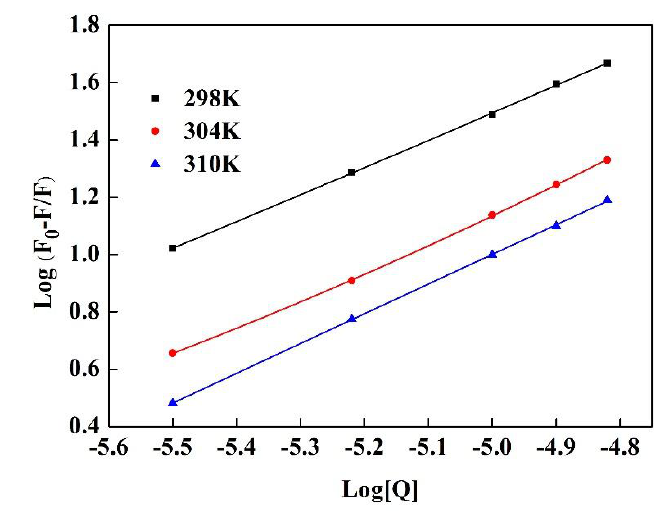
Figure 9. The double-logarithmic curves for the quenching of Pv fluorescence by GA at different temperatures. Table 3. Binding parameters obtained from the interaction of GA with Pv by a double-logarithmic equation.